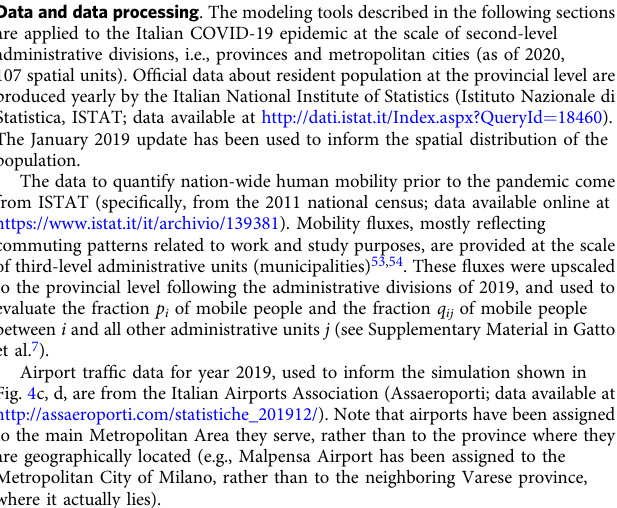
Fig. 4c, d, are from the Italian Airports Association (Assaeroporti; data available at http://assaeroporti.com/statistiche_201912/). Note that airports have been assigned to the main Metropolitan Area they serve, rather than to the province where they are geographically located (e.g., Malpensa Airport has been assigned to the Metropolitan City of Milano, rather than to the neighboring Varese province, where it actually